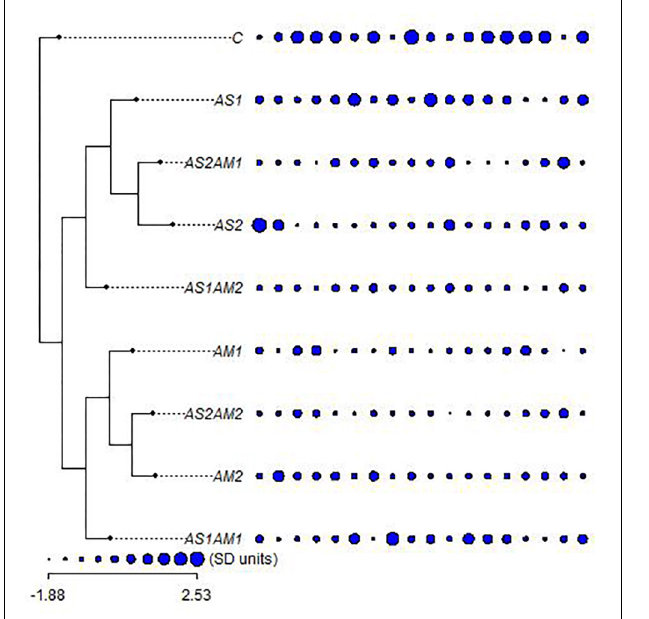
FIGURE 2 | The relationships between arsenic-treated groups of fishes supplemented with Amphora coffeaeformis extract versus the control group with the hematological and biochemical characters (ordered as AST, ALT, ALP, GL, TP, AL, GLO, AG, UR, CR, LDH, RBCs, HB, HCT, MCV, MCH, MCHC, and WBCs) in standard deviation units (SD) (Mesquite and R packages). AS1 (19.2 mg/L arsenic), AS2 (38.3 mg/L arsenic), AM1 (7% Amphora), and AM2 (10% Amphora).